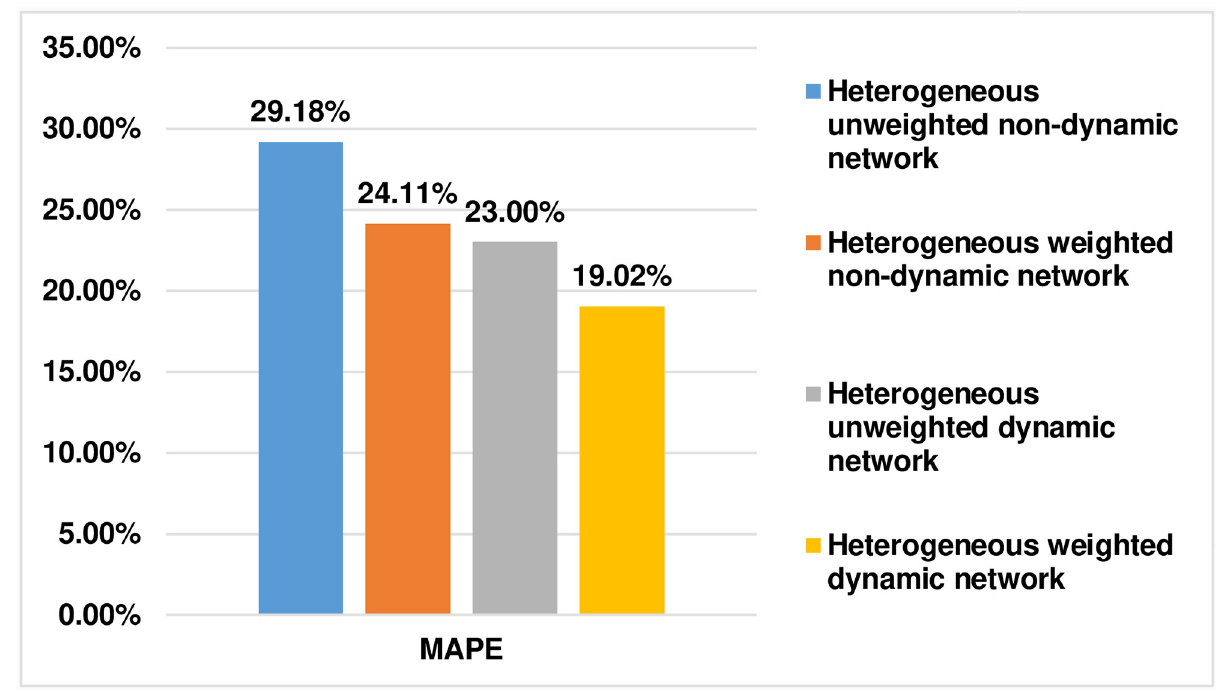
Fig 7. MAPE for various types of heterogeneous networks.